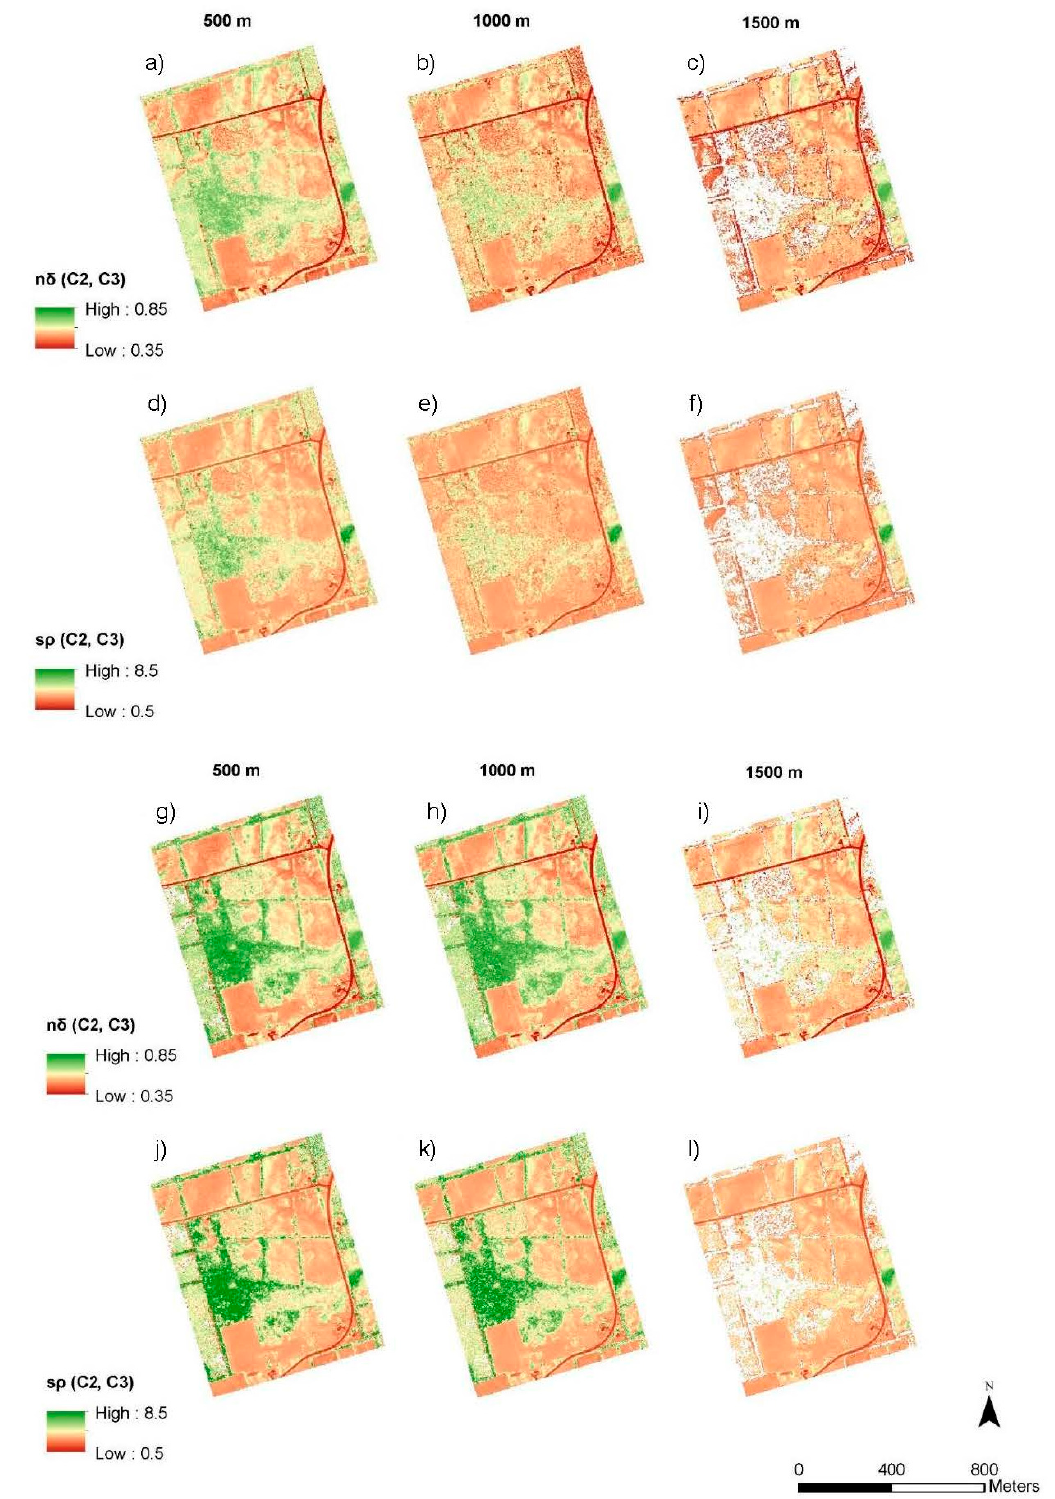
Figure 7. n δ (C2, C3) and s ρ (C2, C3) for all returns ( a-f ) and single returns ( g-l ), averaged over 4 m × 4 m grid. White pixels represent no data.